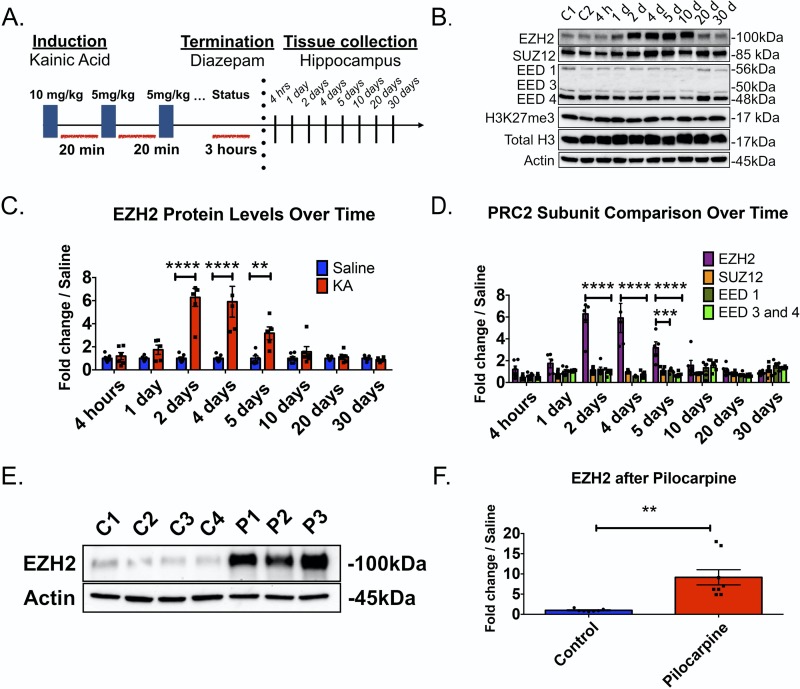
EZH2 protein levels are increased 2–5 days after KA induced SE.(A) Schematic of low dose KA protocol used for Figs 4–7. See Methods for complete description. (B) Representative Western Blot of EZH2, SUZ12, EED-1, EED-3, EED-4, H3K27me3 and Total H3 levels after SE, where C1 = untreated animals, C2 = saline treated animal. Lanes 3–10 represent different KA treated mice sacrificed at time points post SE. C = control, H = hours, D = days. Quantifications of SUZ12, EED-1, EED-3, EED-4, H3K27me3 and Total H3 are located in supplemental information. (C) Quantification of EZH2 protein western blots across time. EZH2 exhibits a robust, prolonged increase in protein levels beginning with a 6.3-fold increase compared to saline animals 2 days after SE. This increase remains statistically significant out to 5 days. (D) Graph demonstrates fold change in EZH2 protein levels relative to other PRC2 subunit components. Relative fold change of EZH2 in KA animals is significantly greater than fold changes detected for SUZ12, EED-1 and EED-3 and EED-4 proteins at 2, 4 and 5 days. (E) Representative Western blot of hippocampi extracted 48 hours after pilocarpine treatment in rats. C = saline treated controls. P = Pilocarpine treated. See methods for complete description of induction paradigm used. Each band represents one hippocampal hemisphere from one rat. We find that EZH2 levels are up regulated 14.7-fold after SE. (F) Quantification of EZH2 protein from all tested pilocarpine rats (n = 7 saline controls, n = 8 pilocarpine). For panels C-D, statistical significance was assessed across animals, time, and conditions through Two-way ANOVA test where p < 0.05 with Holm-Sidak correction for multiple comparisons. n = 7 for saline treated animals and n = 5–7 KA animals at every time point. For Panel F, statistical significance was assessed by unpaired Student’s t-test. *p <0.05, **p < 0.01, ***p< 0.001, ****p <0.0001.